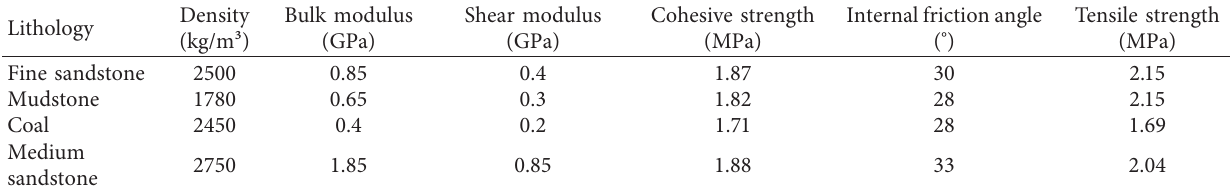
Table 4: Major parameters of rock mechanics.